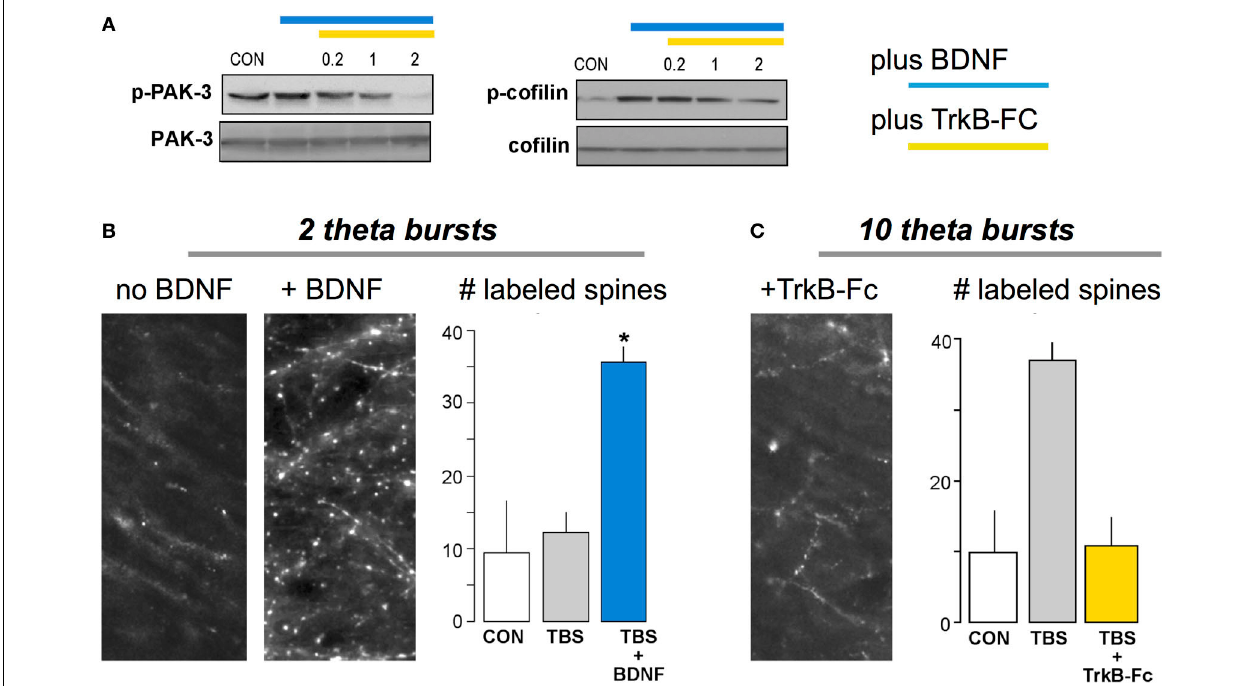
FIGURE 4 | BDNF enhances theta burst induced actin signaling and cytoskeletal assembly at hippocampal synapses. (A) Brief infusion of BDNF (60ng/ml) into adult hippocampal slices increases phosphorylation of PAK and cofilin (immunoblots), two of the signaling proteins included in the schematic for LTP consolidation ( Figure 3 ). Phosphorylation was blocked by addition of the extracellular BDNF scavenger TrkB-Fc (applied at 0.2–2 µ g/ml). There were no evident effects of either treatment on levels of total PAK or cofilin. (B) Labeling of filamentous (F-) actin with fluorescence-tagged phalloidin applied to slices 10min after delivery of two theta bursts (TBS), a number too small to generate LTP if applied